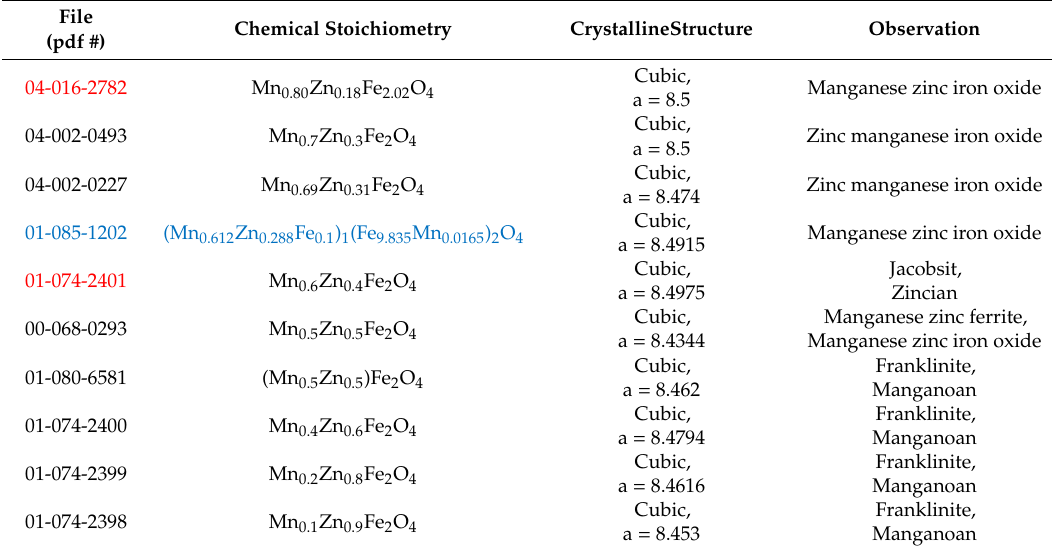
Figure 2. Scanning electron microscopy (SEM) of the MnZn ferrite revealing the granular microstructure, with grains typically below 20 µ m in diameter. Table 1. Chemical composition, crystalline structure, and lattice parameter for the Mn a Zn (1 − a) ferrite compositions, where a = 0.1 to 0.8, and the corresponding XRD powder di ff raction database (pdf)